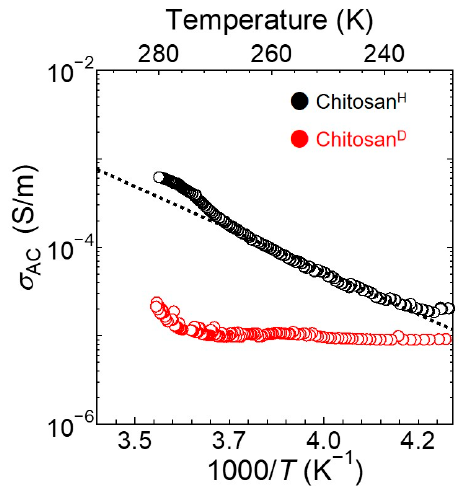
Figure 2. Temperature dependences of the ionic conductivities ( σ AC ) of Chitosan H and Chitosan D .